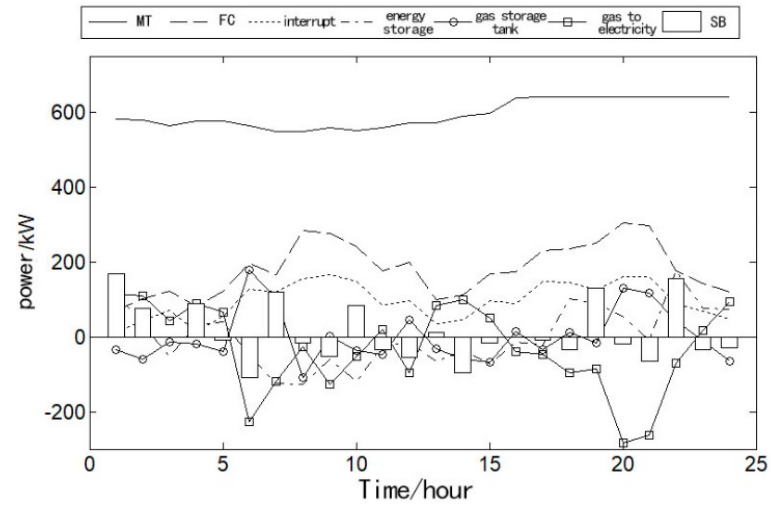
Figure 3. Optimizing economic dispatch scheme for integrated energy system in scenario 1.